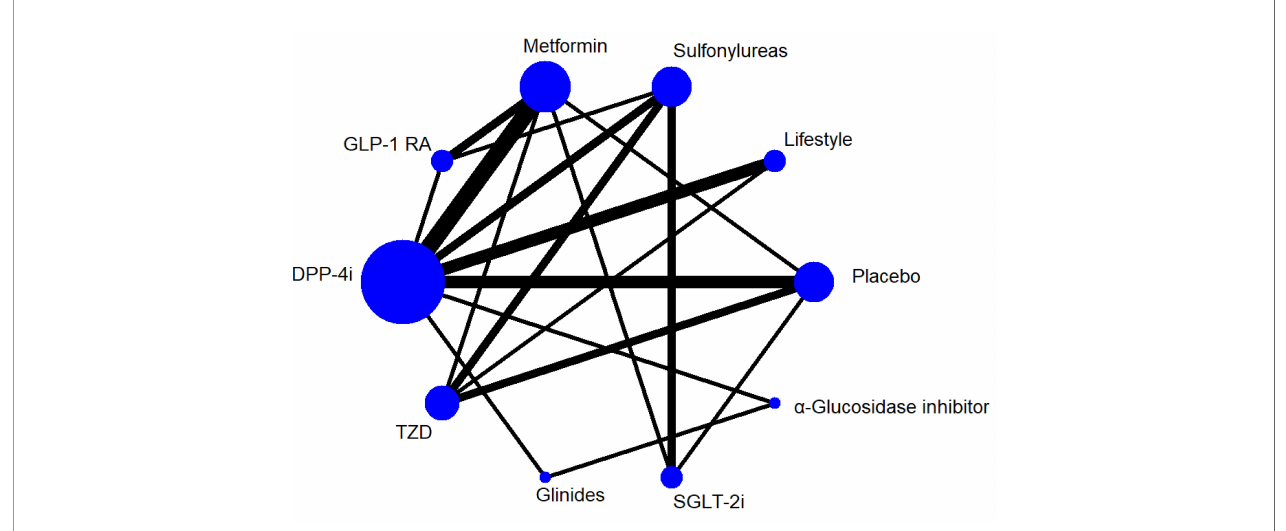
FIGURE 2 | Network Plot for all studies. GLP-1 RA, glucagon-like peptide-1 receptor agonist. SGLT-2i, sodium-glucose co-transporter 2 inhibitor. DPP-4i, dipeptidyl peptidase-4 inhibitor. TZD, Thiazolidinedione. Lifestyle,exercise and/or